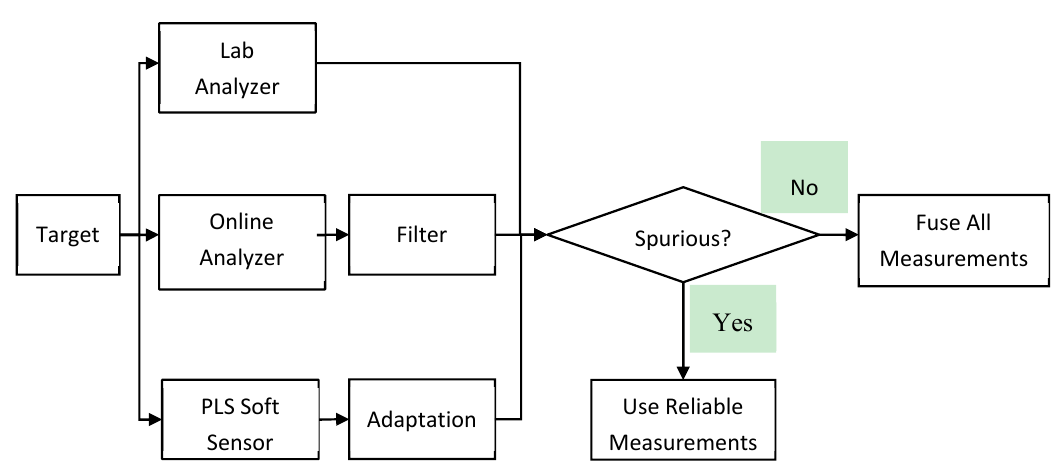
Figure 1. Proposed multi-rate and judicious sensor fusion scheme. Table 2. Steps of the Proposed Sensor Fusion